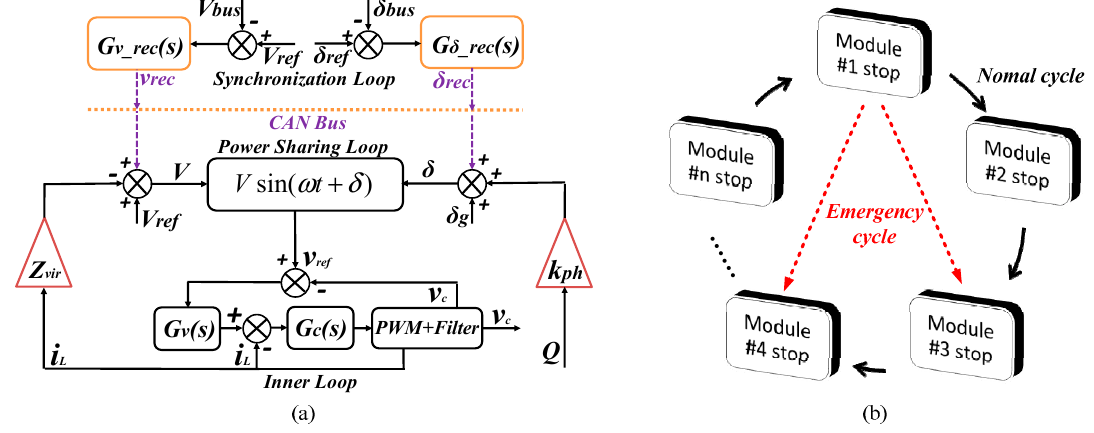
Figure 2. Control mechanism for modular UPS system: ( a ) overall control; and ( b ) plug’n’play control mechanism. PWM: pulse width modulation. Table 2. Transient time requirements.